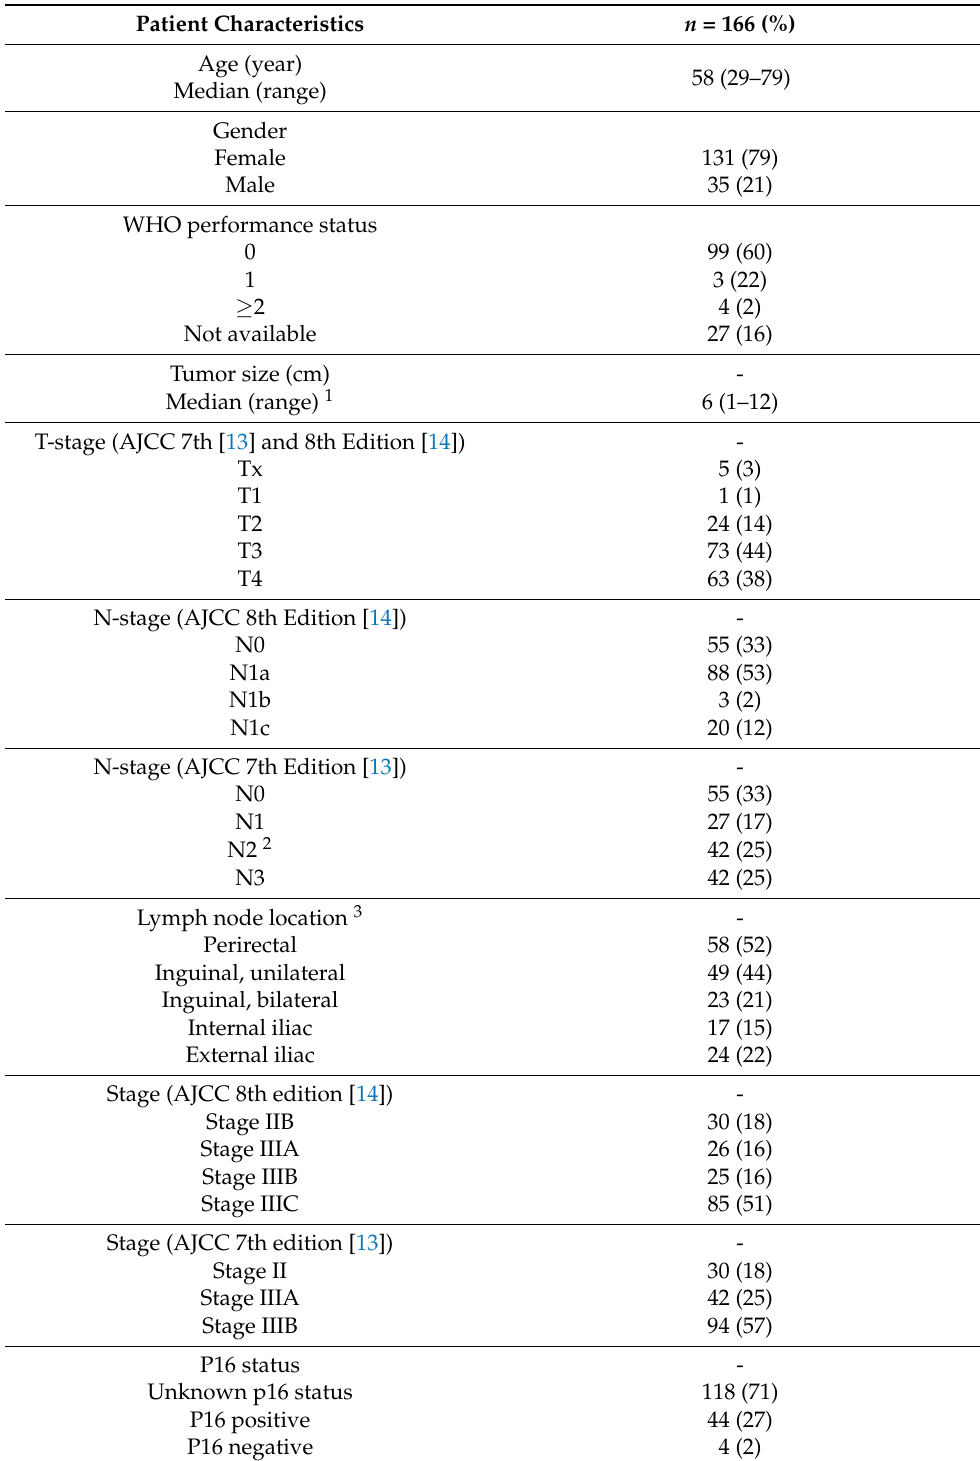
Table 1. Pre-treatment